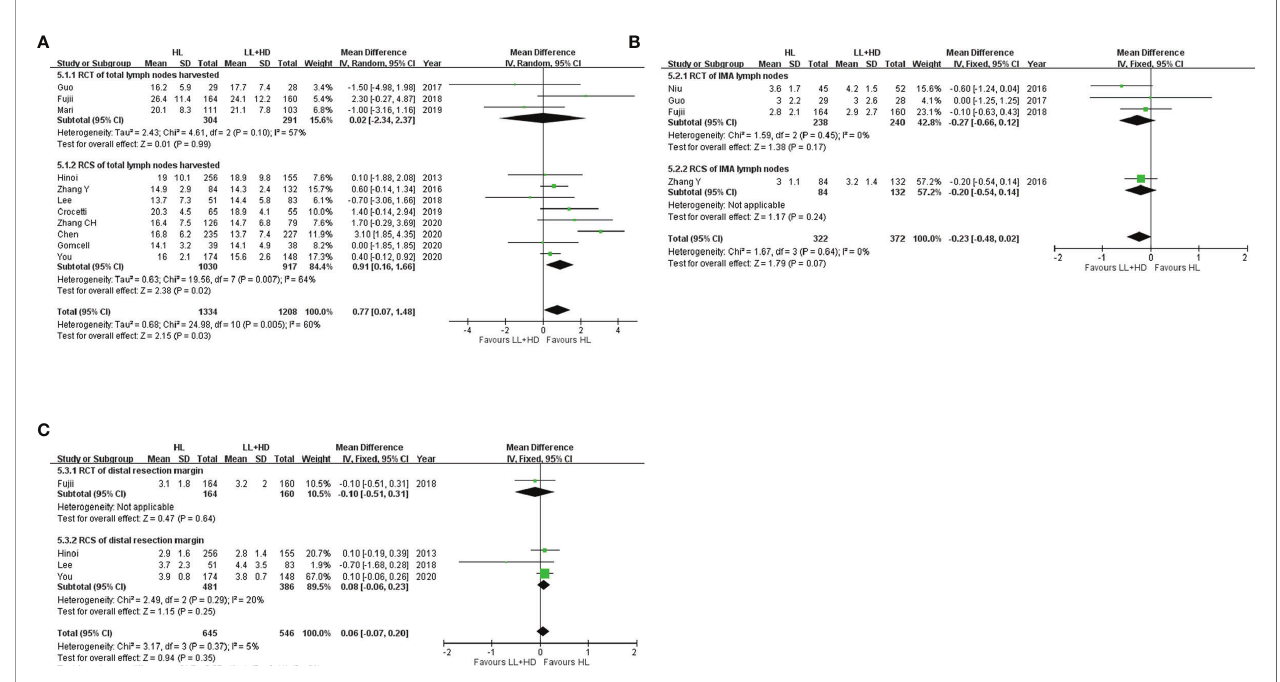
FIGURE 5 | Meta-analysis of surgical quality. (A) Forest plot of the total lymph nodes harvested with HL versus LL+HD. (B) Forest plot of IMA lymph nodes harvested with HL versus LL+HD. (C) Forest plot of the distal resection margin with HL versus LL+HD. HL, high ligation of the inferior mesenteric artery; LL+HD, low ligation of the inferior mesenteric artery plus high dissection of lymph nodes; IMA, inferior mesenteric